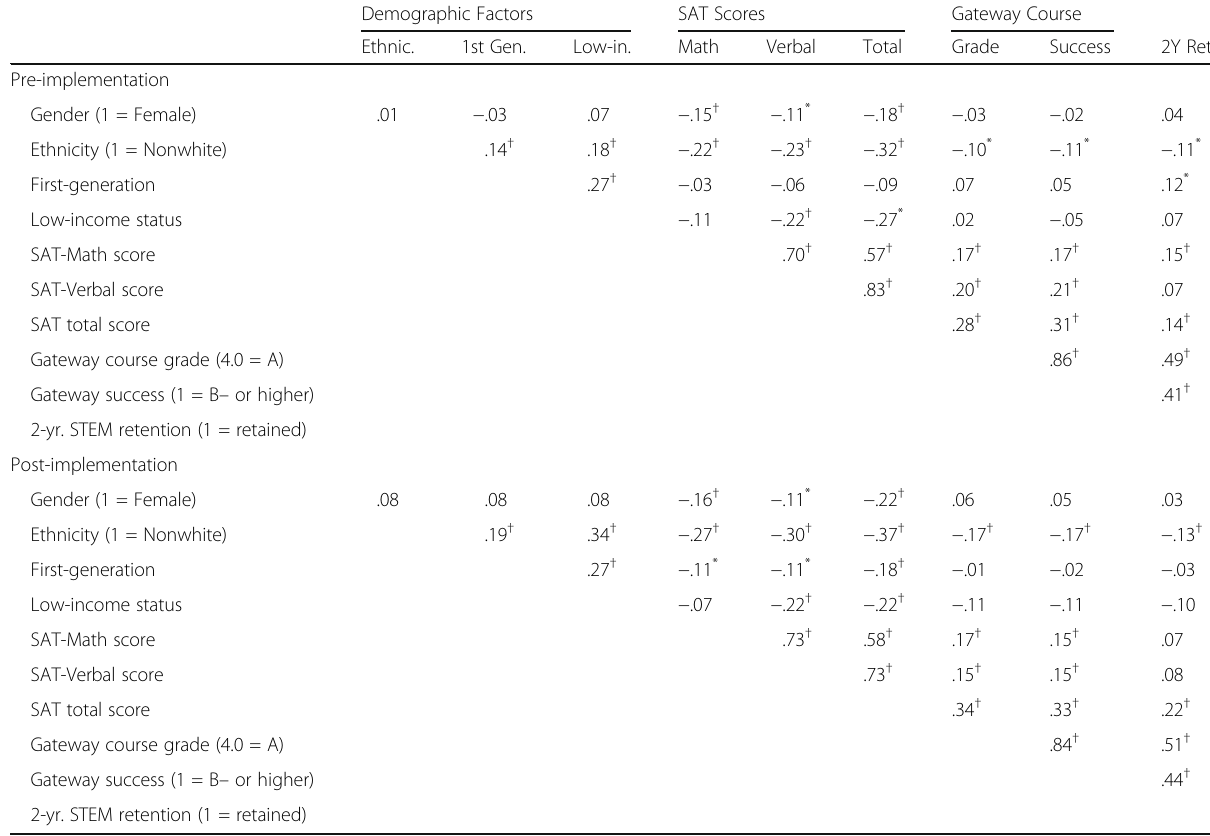
Table 5 Pearson pairwise correlations between demographic factors, SAT scores, and outcome variables pre- and post- implementation. Significant correlations are marked * ( p < 0.05) and † ( p < 0.01) Demographic Factors SAT Scores